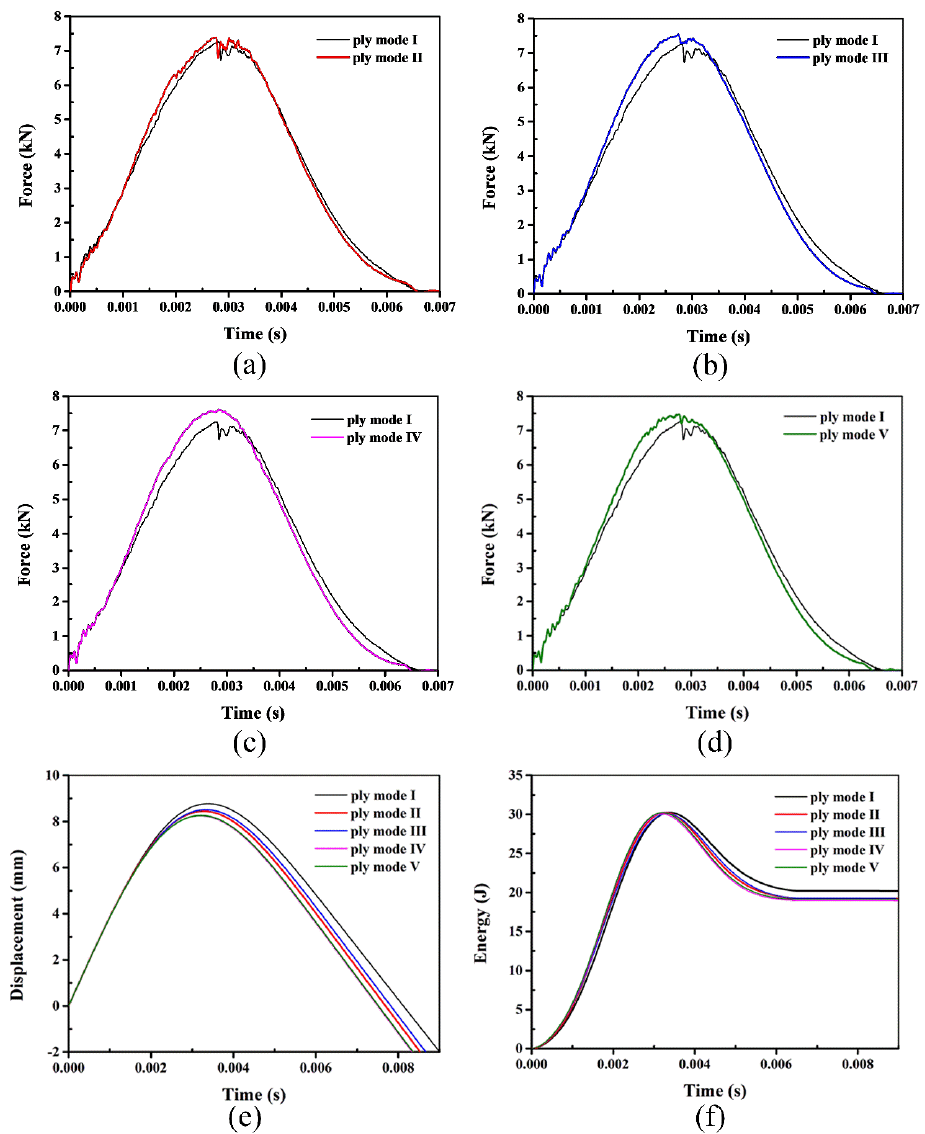
Figure 9. Typical impact behavior of laminates with 30 J (Figures ( a – d ) show the force-time curves of mode I with mode II, mode III, mode IV and mode V, respectively. Figure ( e ) and Figure ( f ) represent the displacement-time and energy-time histories of different modes, respectively).